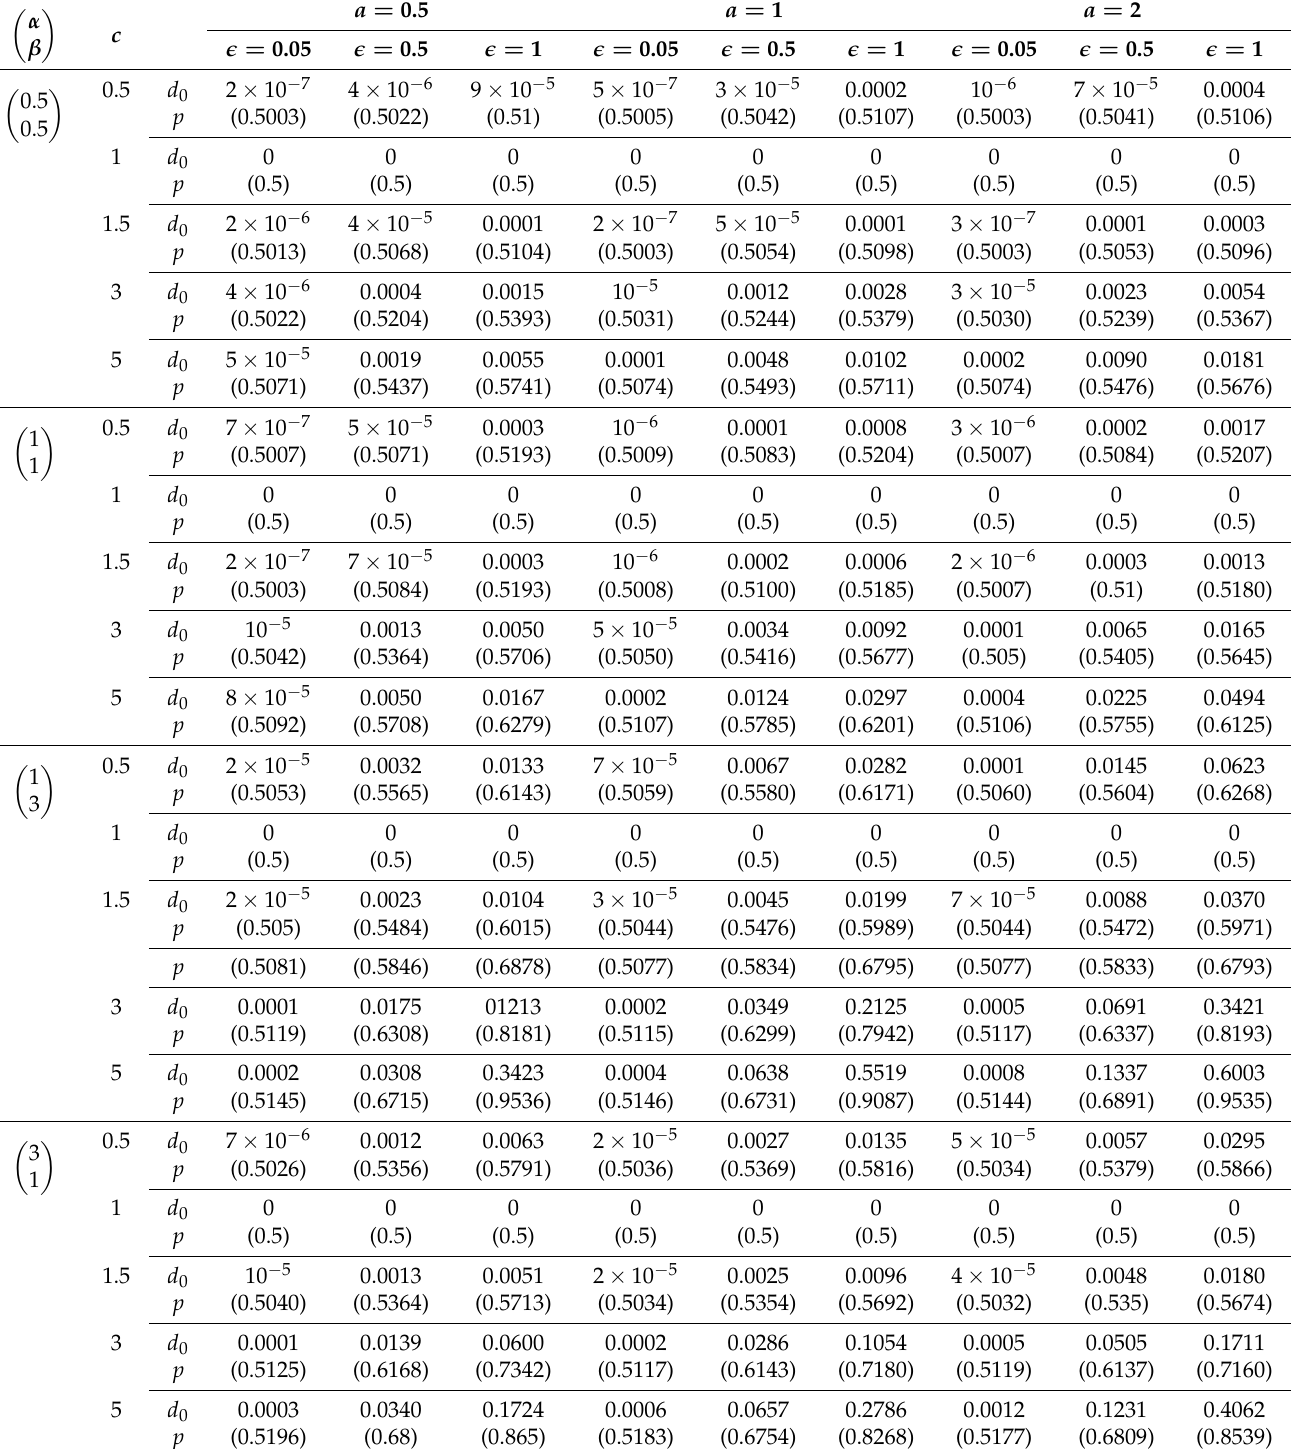
Table 2. Values of d 0 and p in (6) (for a (cid:54) = 1) and (7) (for a = 1) under class (1) for a sample generated from